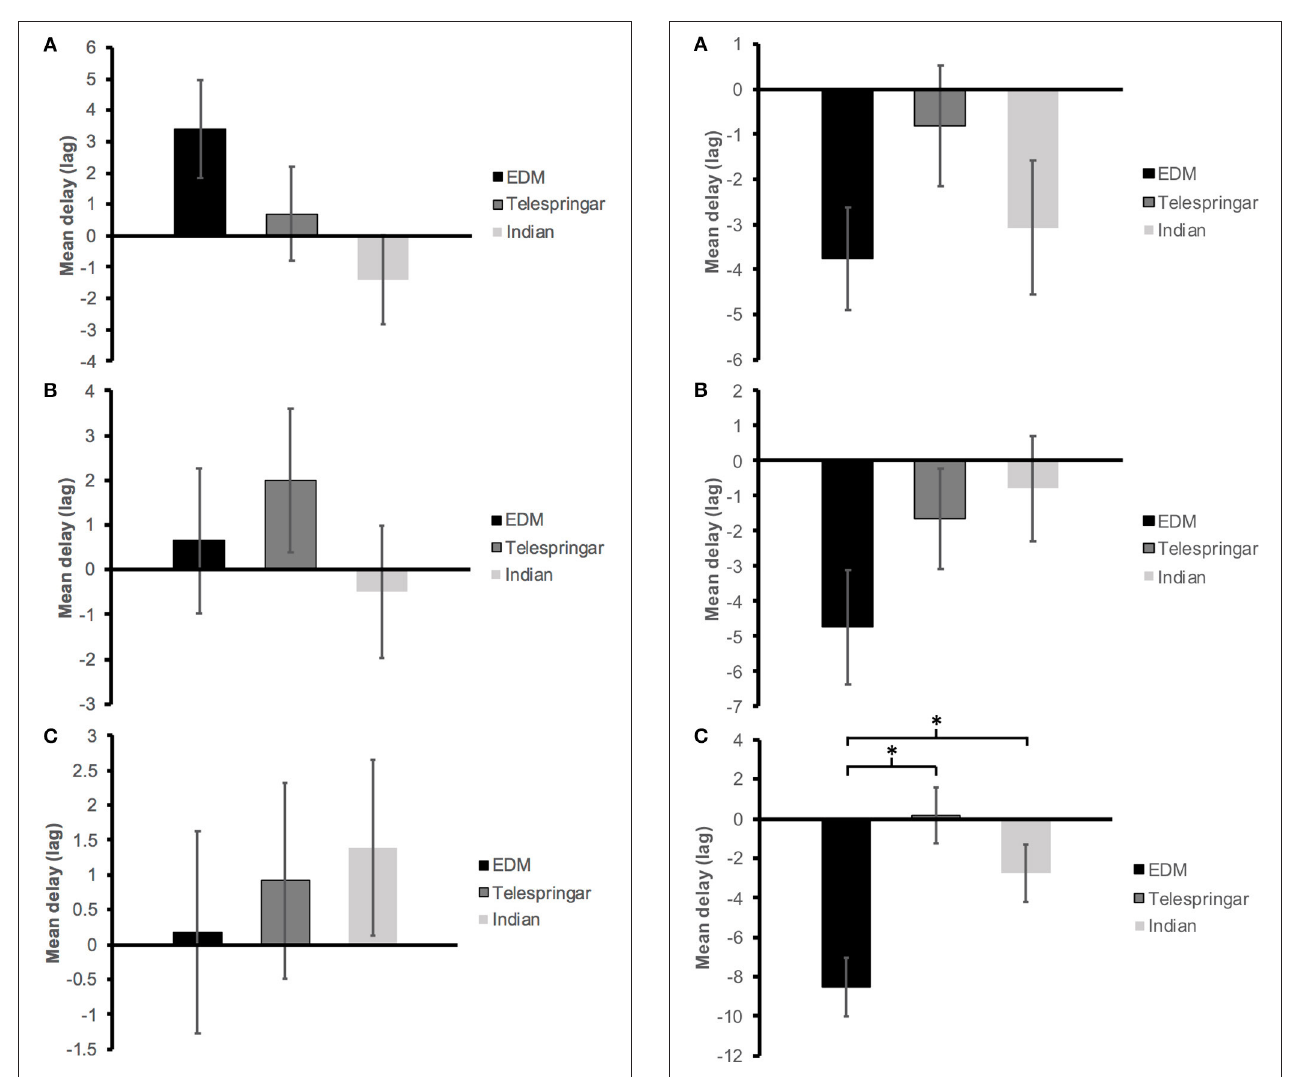
(brightness) and both 3D and vertical QoM. Delay between spectral centroid and QoM was negative for vertical QoM across all stimuli. The observed negative delay pattern for vertical motion across stimuli could suggest a level of anticipation to perceived brightness events in the